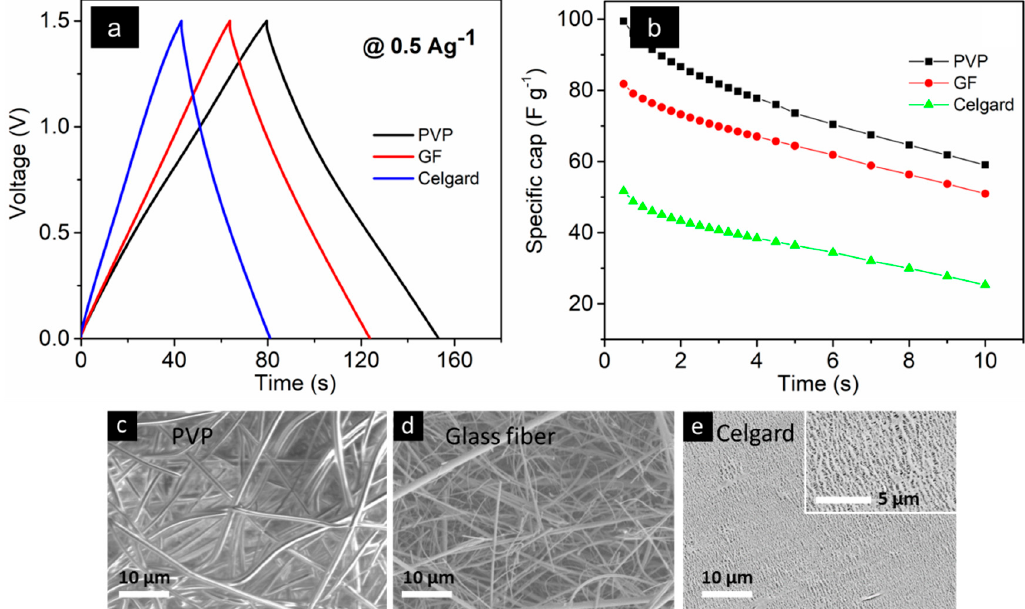
Figure 7. Measurements of supercapacitor devices including ( a ) GCD plots and ( b ) capacitance variations at different current densities. The measurements were done on an MSC with an AC electrode, a 1-ethyl-3-methylimidazolium acetate (EmImAc) ionic liquid electrolyte, and three different separators. ( c – e ) SEM images of polyvinylpyrrolidone (PVP), Glass fiber, and Celgard separators, respectively.